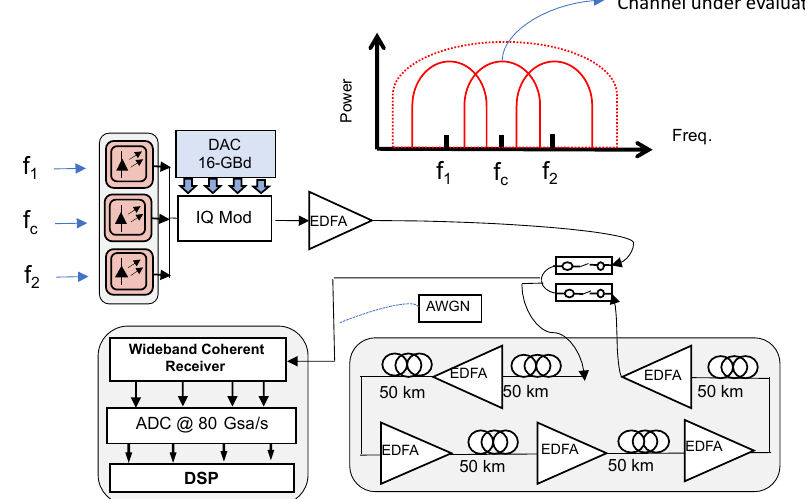
Figure 6. Experimental setup of the Gridless Nyquist-WDM system affected by Inter-Channel Interference